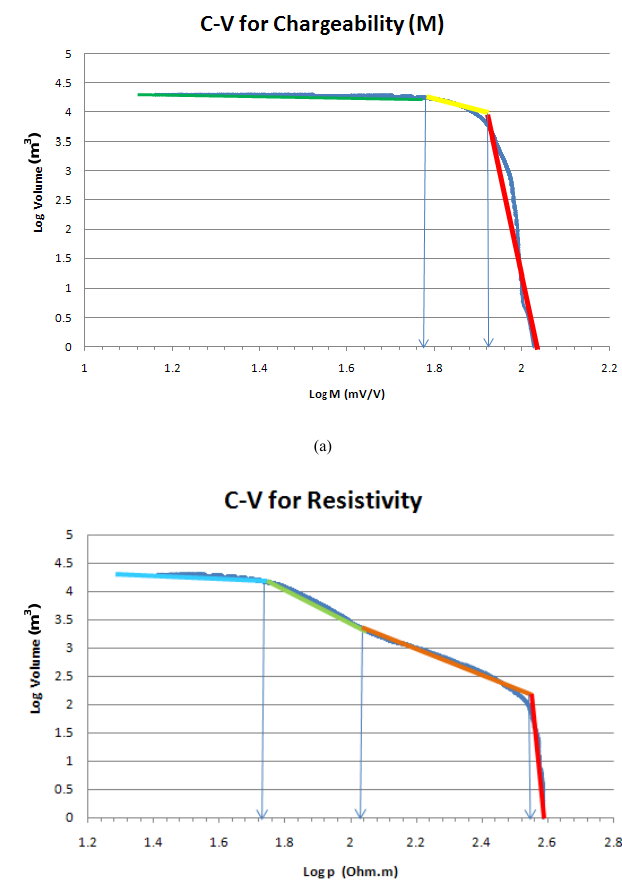
Fig. 3. Log-log plots of volume versus chargeability (a) and resis- tivity (b) in the Nowchun